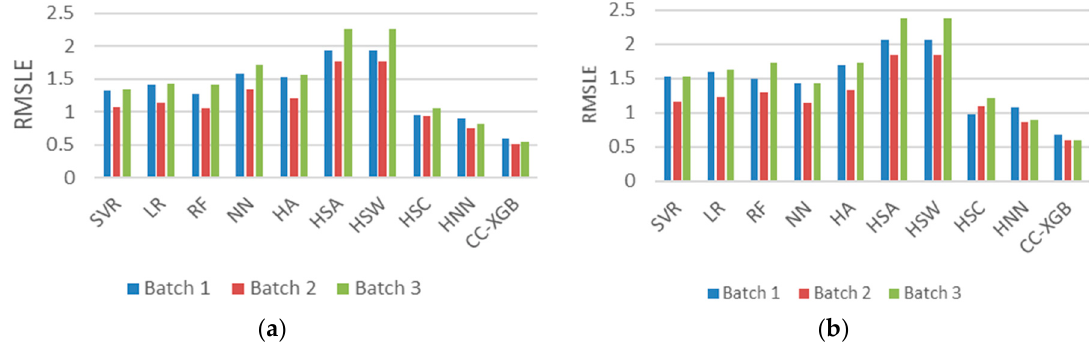
Figure 6. Performance of baselines. ( a ) represents the rental demand and ( b ) represents the drop-off one.